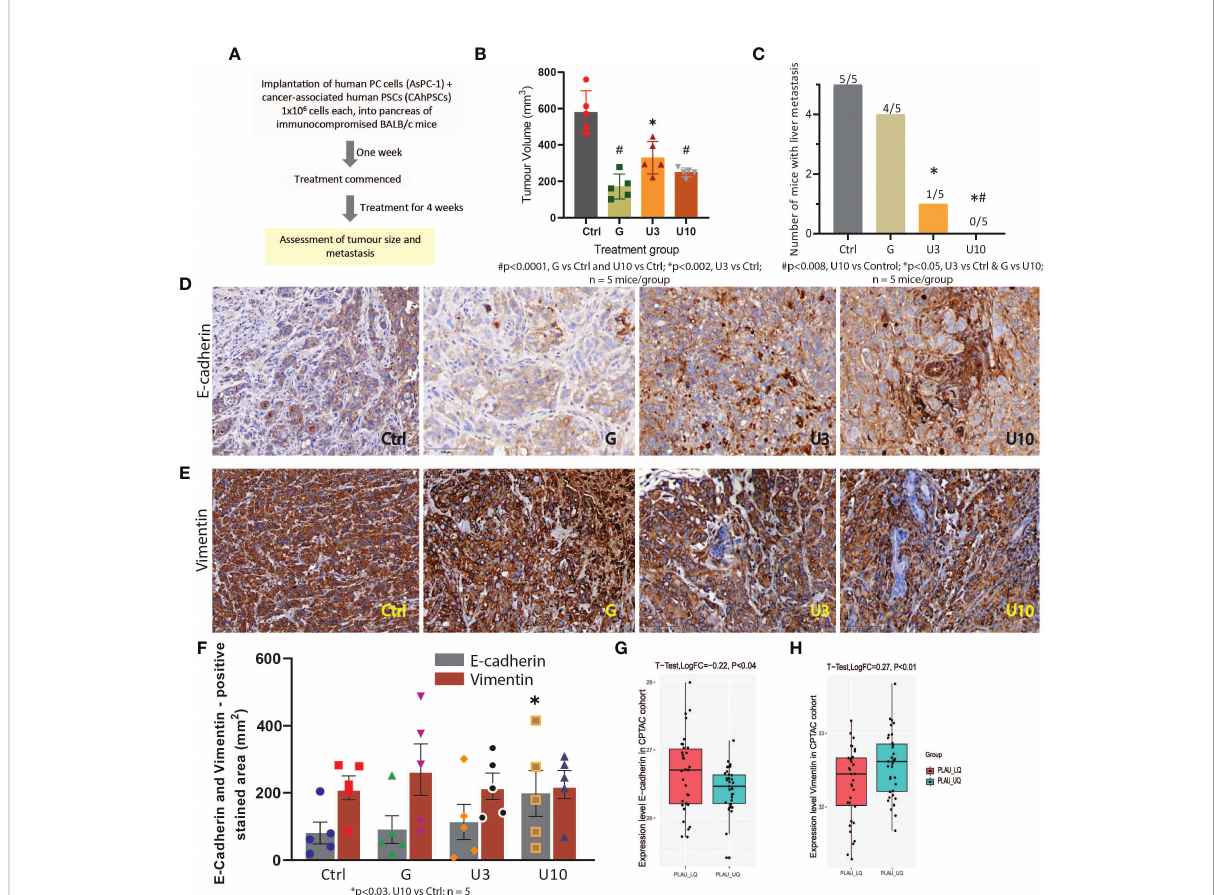
FIGURE 14 In vivo study to assess the effects of PLAU/uPA inhibition and Gemcitabine on tumour progression in an orthotopic model of pancreatic cancer (A) Flowchart depicting study design for the orthotopic model. (B) Effects of Gemcitabine (G) , uPA inhibitor BB230F 3 and 10 mg/kg body weight (U3) (U10), respectively, on endpoint primary tumour volume. Mice bearing orthotopic pancreatic tumours received G, 75 mg/kg body weight twice weekly or U3 or U10 by daily intraperitoneal injections for 28 days. Both gemcitabine and uPA inhibitors signi fi cantly reduced tumour volume (n = 5 mice/group). (C) uPA inhibition signi fi cantly reduced (U3) or completely abolished (U10) liver metastases in mice, while Gemcitabine did not have any effect on metastasis compared to untreated controls. (n = 5 mice/group). (D, E) Immunostaining for